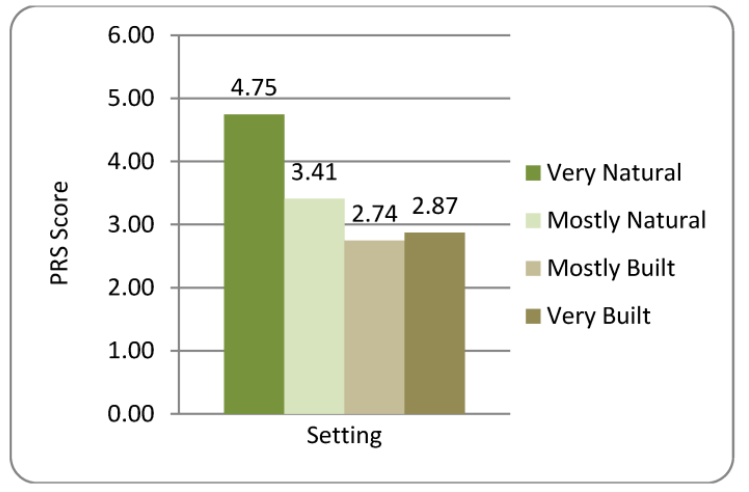
Figure 5. Participant’s ratings of the Perceived Restorativeness of Environmental Settings.